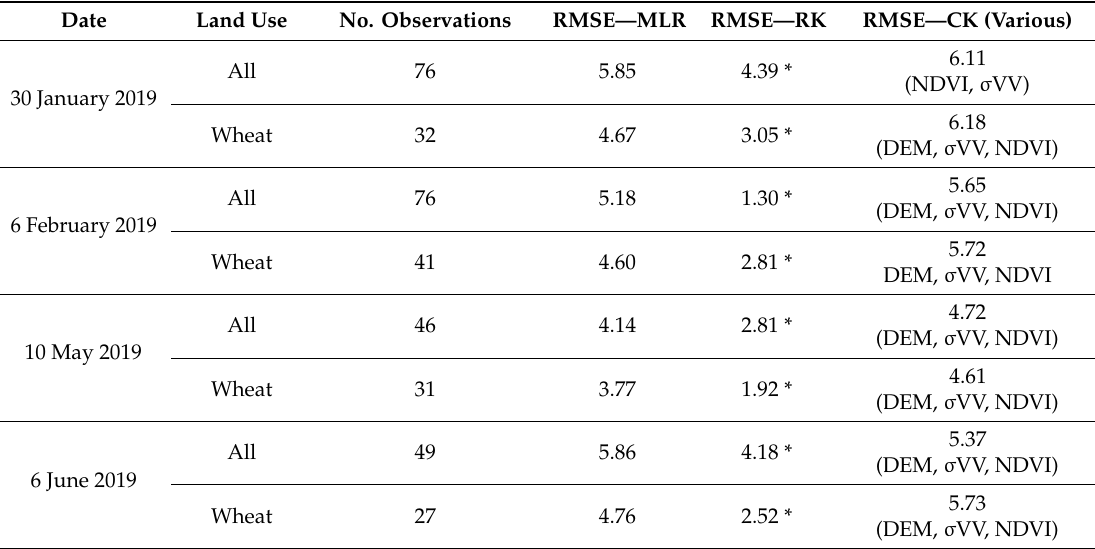
Table 9. Summary of